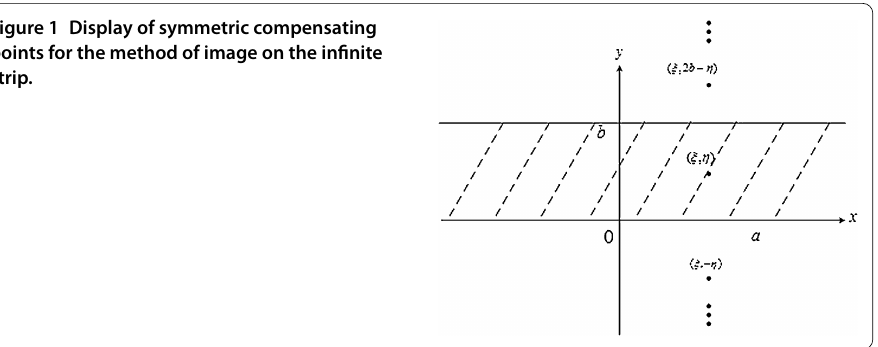
Figure 1 Display of symmetric compensating points for the method of image on the infinite